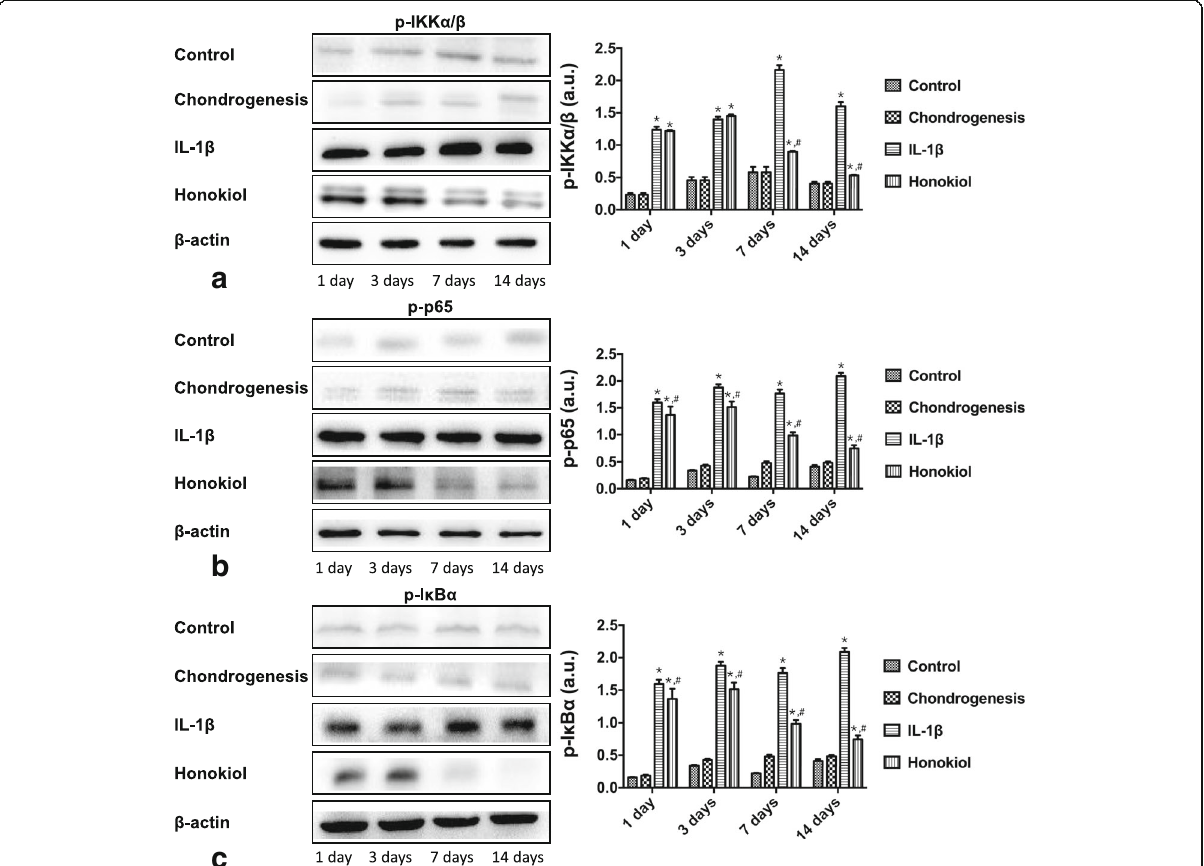
Fig. 8 Honokiol inhibited NF- κ B pathway in hUC-MSCs in a time-dependent manner. 2nd passage hUC-MSCs were cultured in pellets with chondrogenic medium, cells were treated with IL-1 β (10 ng/ml) and honokiol (25 μ M). At 1st day, 3rd day, 7th day and 14th day, the expression of (a): p-IKK α / β , (b): p-p65, (c): p-I κ B α were evaluated by western blot. Integrated density values were analyzed by ImageJ and normalized to β -actin, all results were presented as mean ± SD ( n = 9); p * < 0.01 versus control; p # < 0.01 versus IL-1 β alone (10 ng/ml IL-1 β without